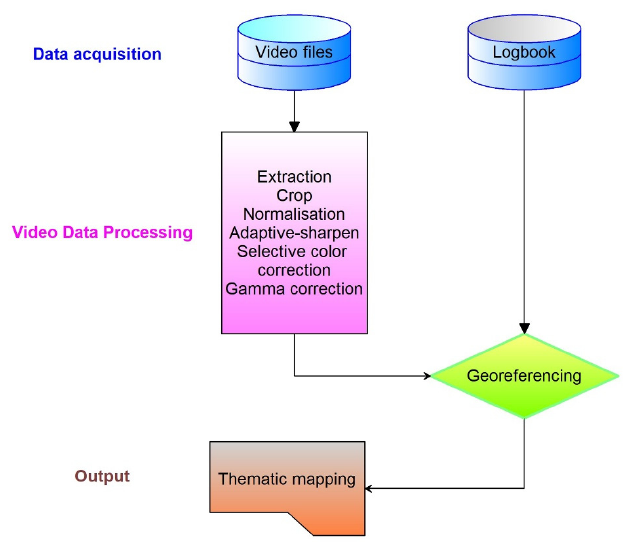
Figure 6. The operative workflow implemented.